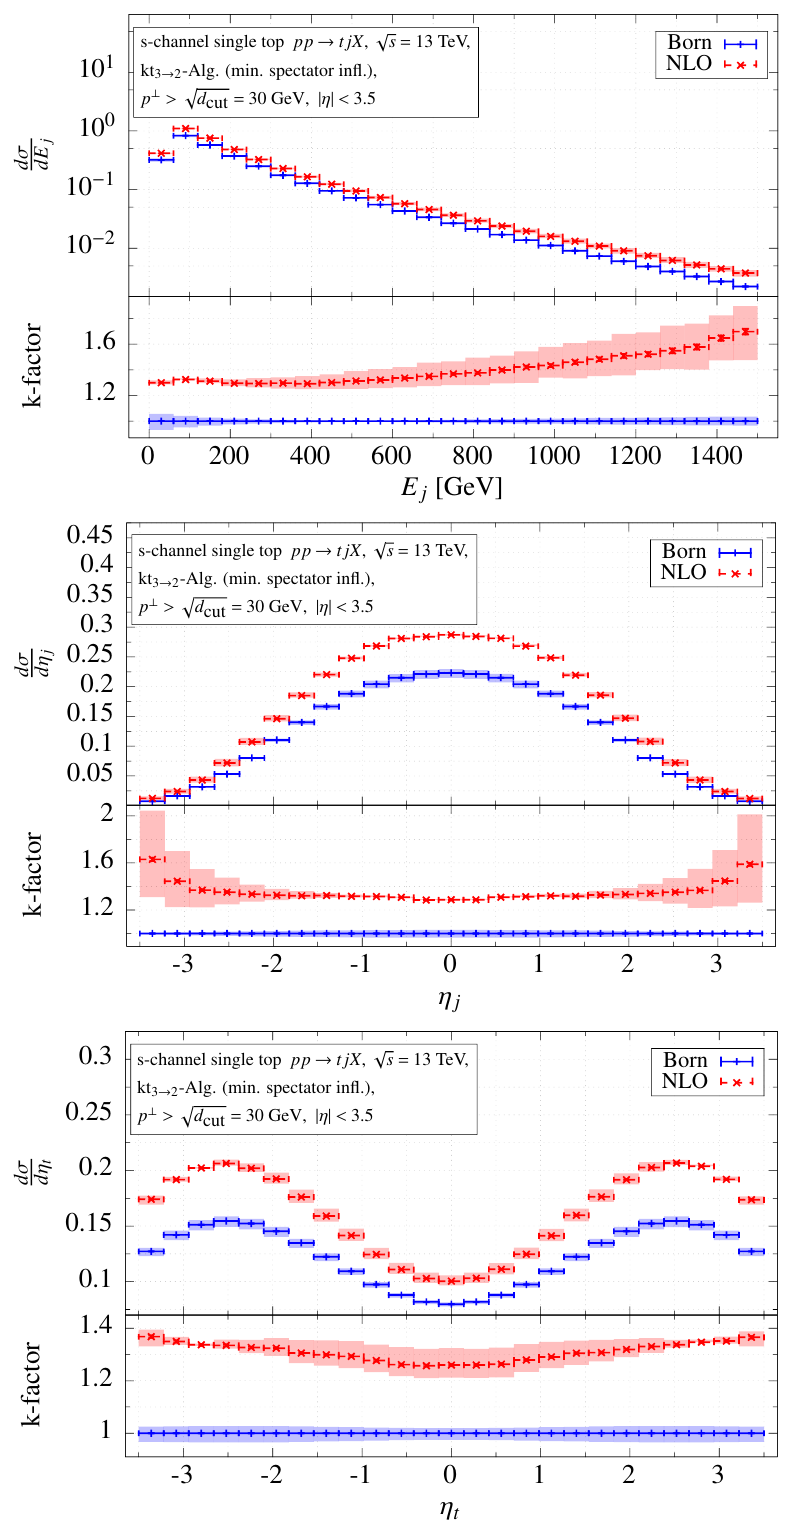
Figure 29 . Same as (cid:12)gure 27 but for the inclusive event de(cid:12)nition.